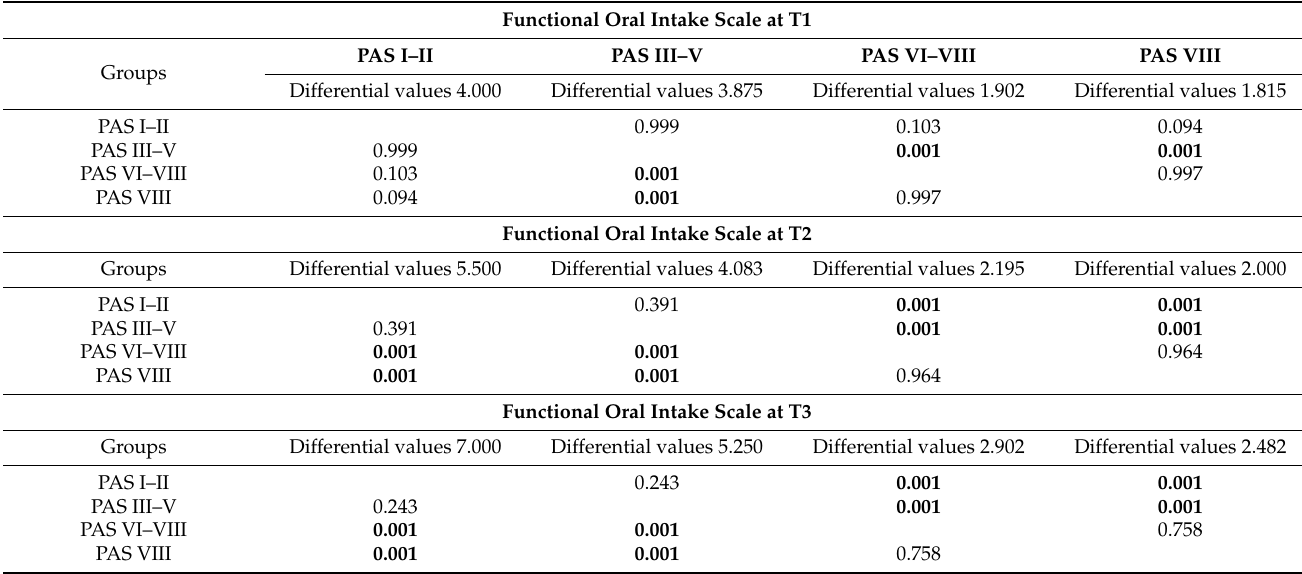
Table 3. Results of posthoc tests for the Functional Oral Intake Scale in the aspects of the Penetration–Aspiration Scale I–II, III–V, VI–VIII, and VIII